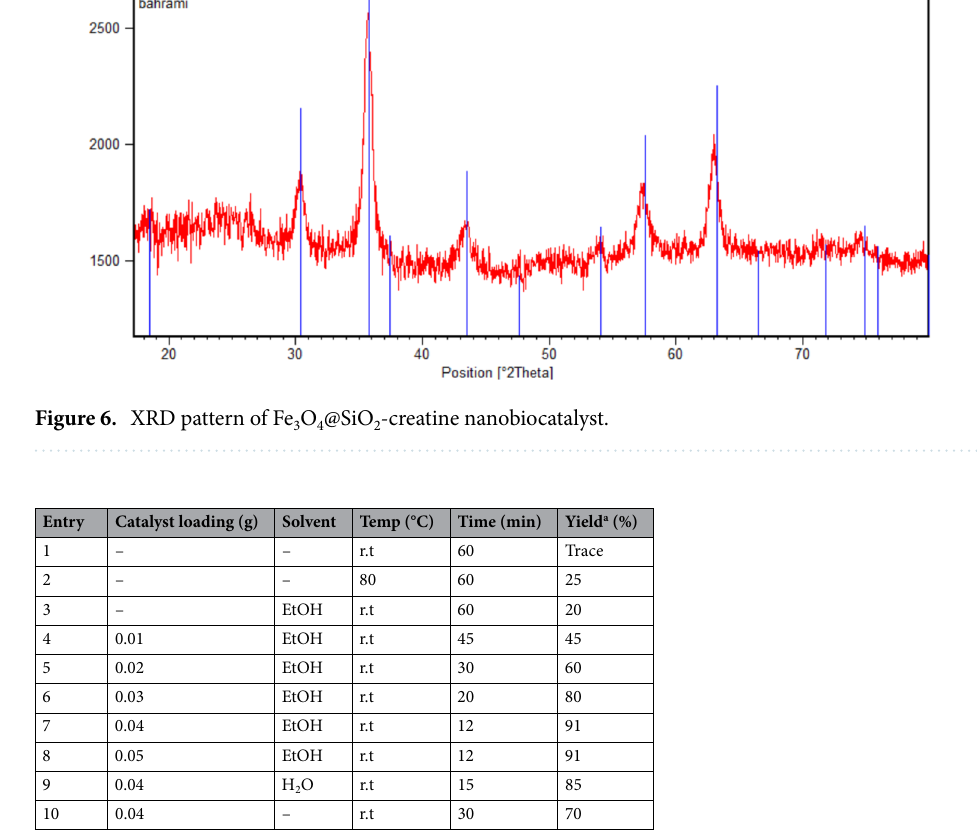
Table 1. Optimizing the reaction conditions in the synthesis of 2 ‐ amino ‐ 4 H ‐ chromene derivatives. a The yields refer to the isolated product 4h .